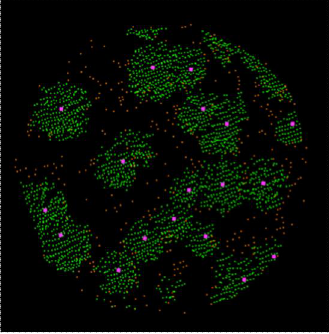
Figure 1. Raw ALS-data with ITD auto detected local maxima points (tree